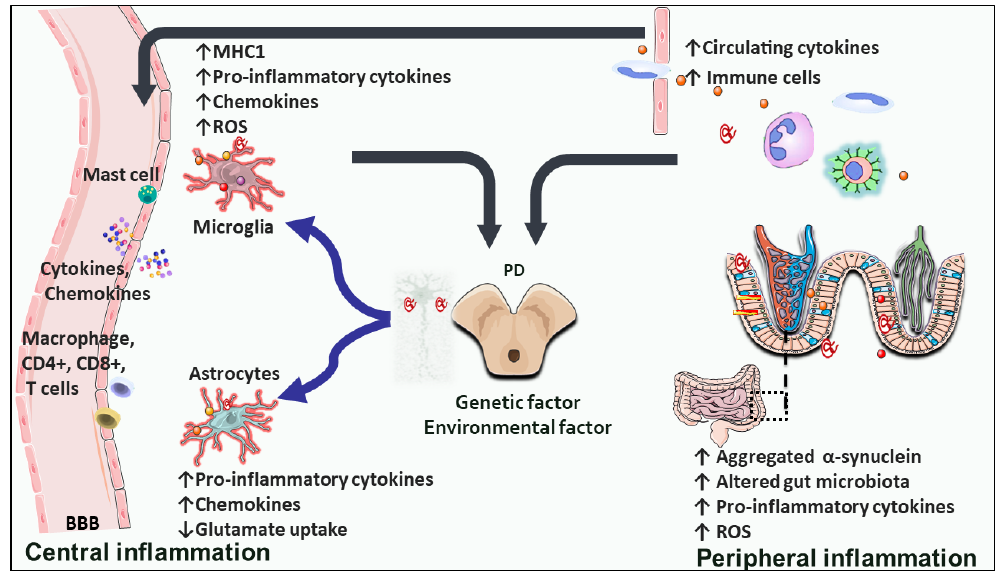
Figure 1. The figure highlights the inflammatory process in PD ( ↑ : increase; ↓ : decrease). The crosstalk between different cell types and intestinal dysbiosis with peripheral inflammation leads to increased circulating pro-inflammatory cytokines and immune cell activation. The hallmarks of a pro-inflammatory immune phenotype in PD include crossing the BBB and infiltrating immune cells from the periphery into the CNS. The two wavy, blue arrows indicate that dead or injured dopaminergic neurons and misfolded or aggregated proteins activate microglia and astrocytes, potentially resulting in a vicious circle. Abbreviations: BBB: blood-brain barrier; MHCI: major histocompatibility complex I; PD: Parkinson’s disease; ROS: reactive oxygen species.